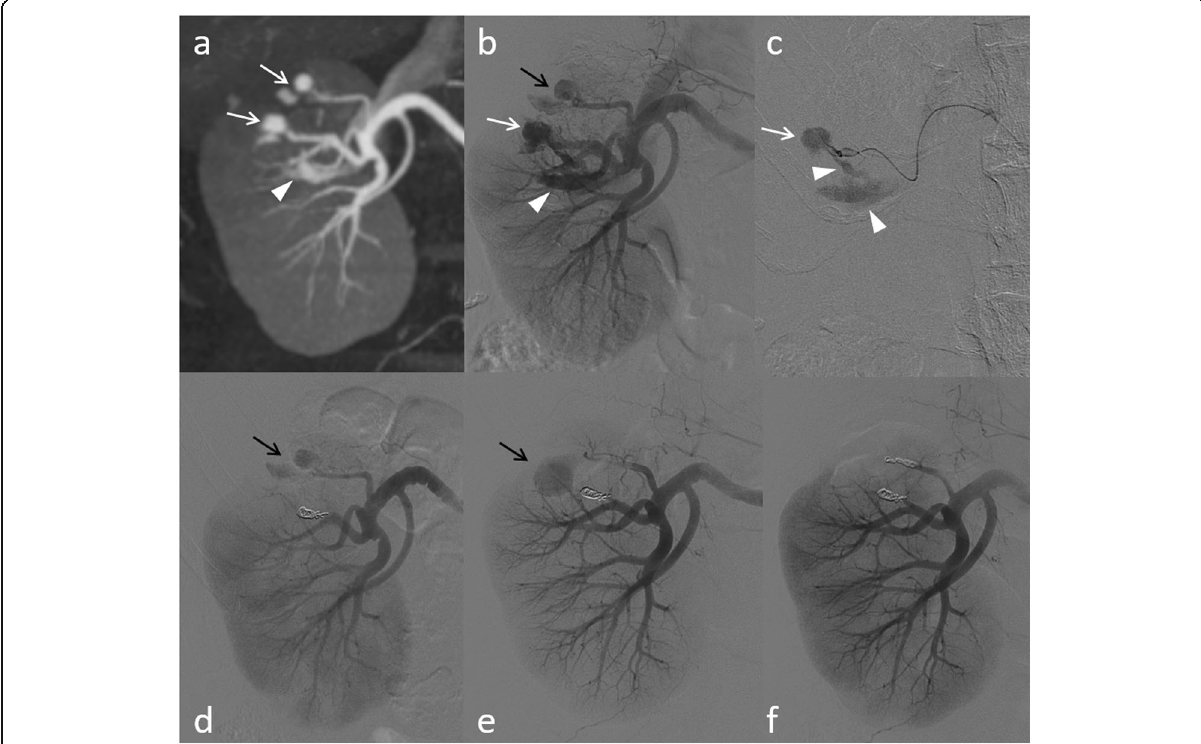
Fig. 2 A case of undergoing transarterial embolization (TAE) twice in a 75-year-old man. a Two renal artery pseudoaneurysms (RAPs) (arrows) with arteriovenous fistula (AVF) (arrowhead) are observed on contrast-enhanced CT on postoperative day (POD) six. b , c , d Although one RAP (white arrows) with AVF (arrowheads) can be embolized using microcoils on POD eight, the other RAP (black arrows) cannot be embolized because of the difficulty of cannulation due to the acute angle of the branch. e , f The remaining RAP (black arrow), which is increased in size, is successfully embolized using microcoils at the second TAE after readmission with hematuria on POD